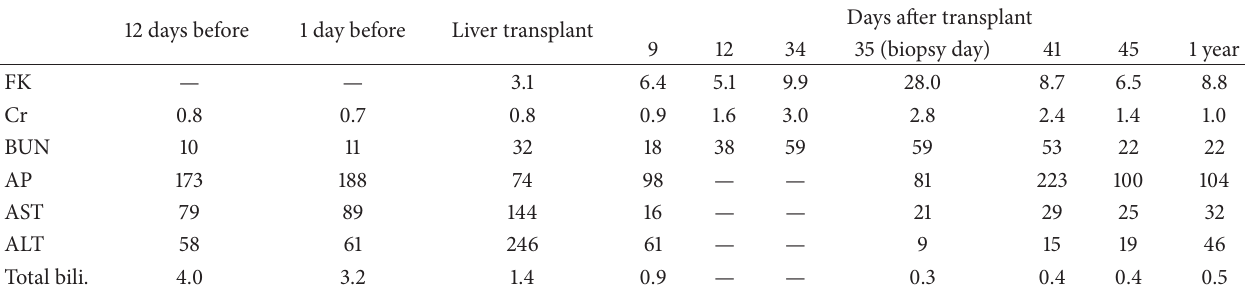
Table 1: Flowchart of serum tacrolimus levels and clinical hepatic and renal indices in index